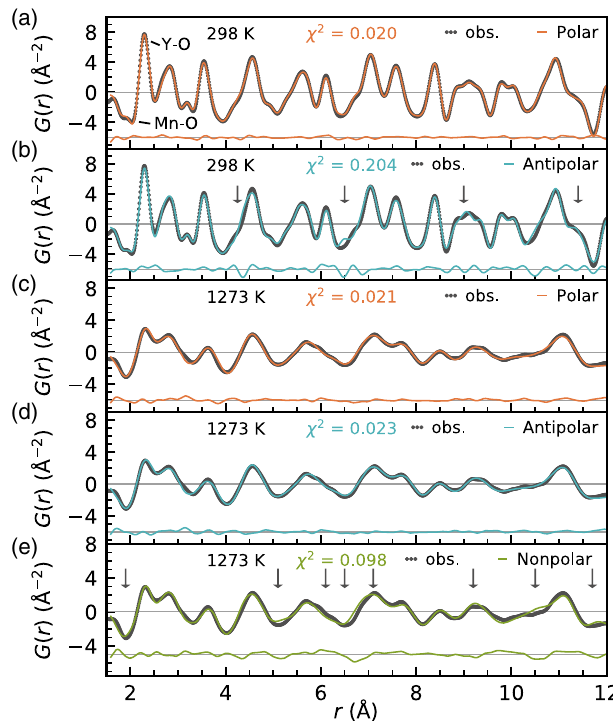
FIG. 4. Fits of the crystallographic models to the PDF data. The G ð r Þ at 298 K fitted over the range r ¼ 1 . 6 – 12 Å by the (a) low- symmetry P and (b) AP models. Corresponding difference curves are shown beneath the PDFs, and the overall fit residuals χ 2 are as indicated. Fits to the 1273 K G ð r Þ data by the low-symmetry P and AP models over the same r range are shown in panels (c) and (d), respectively. (e) Fit of the high-symmetry NP model to the 1273 K PDF data: Arrows mark regions of particularly bad fits. High fit residual and eventful difference curves demonstrate that the nonpolar model does not provide an adequate description of the local structure of the high-temperature phase. Fits of the PDF data for additional temperatures are shown in Figs. S10 and S11 of the Supplemental Material